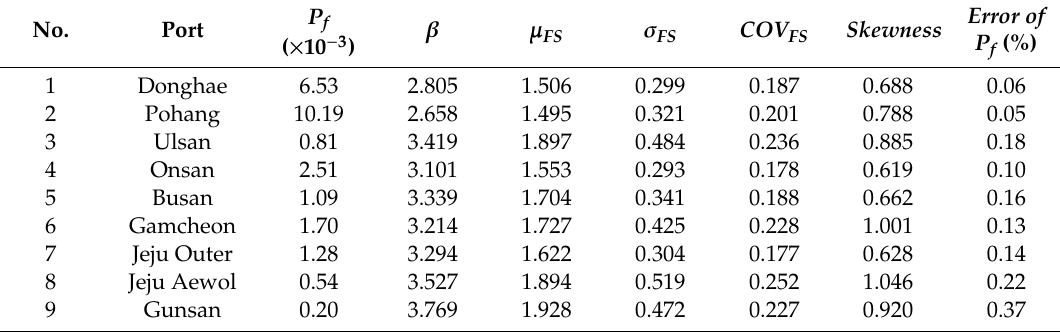
Table 6. Results of the bearing capacity safety factor using Monte Carlo